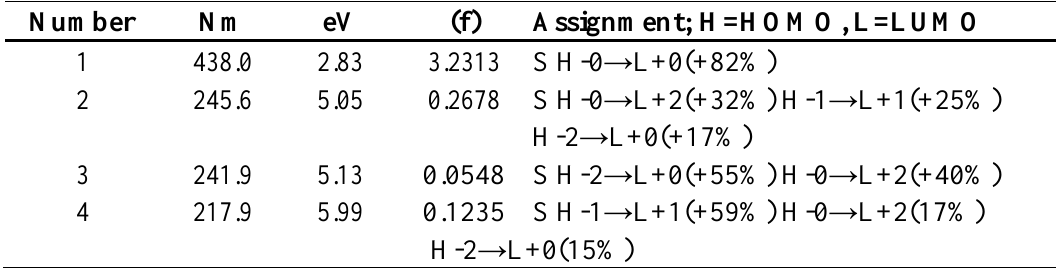
Table 1. Electronic transition states of crocetin (nm, eV, oscillator strengths (f), and transition assignments) as calculated with TD-DFT and the M05-2X/6-31+G(d,p) level of theory. Only the transition states with f > 0.02 are shown.